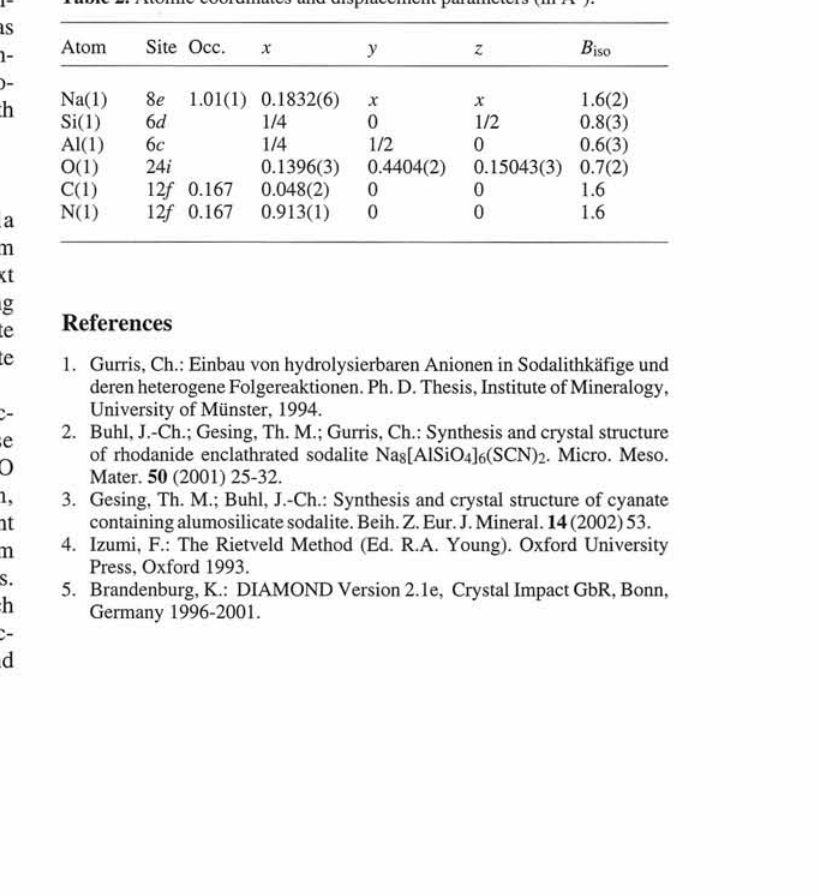
Table 2. Atomic coordinates and displacement parameters (in